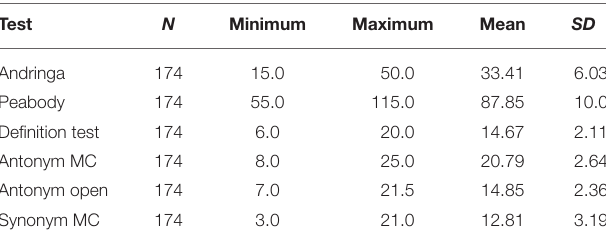
TABLE 5 | The distribution of test scores in all six vocabulary tests in Experiment 2.